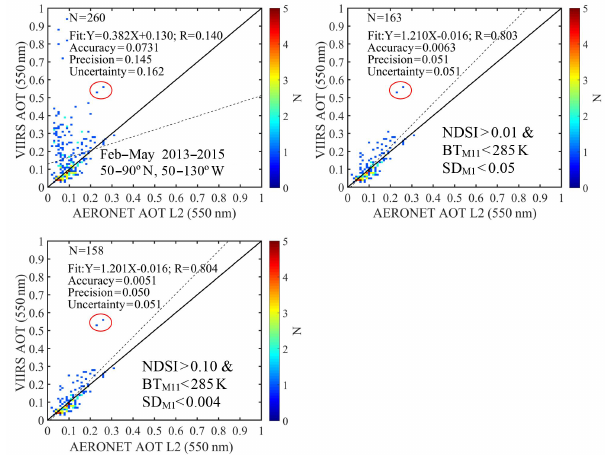
Figure 6. Matchups of the VIIRS good-quality AOD retrievals with AERONET over 50–90 ◦ N, 50–130 ◦ W during boreal spring February–May 2013–2015: (a) with the old VRA-based internal snow test; (b) with the new snow and snowmelt screening scheme and the thresholds used in the Mx8.10 IDPS algorithm; and (c) with the new snow and snowmelt screening scheme but the thresholds used in the EPS algorithm. The two anomalous points with higher positive biases in the red circles were found to be more related to the AOD retrieval itself rather than snow